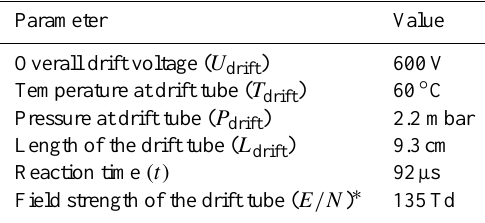
Table 1. Principal operational settings for PTR-TOF-MS parame-